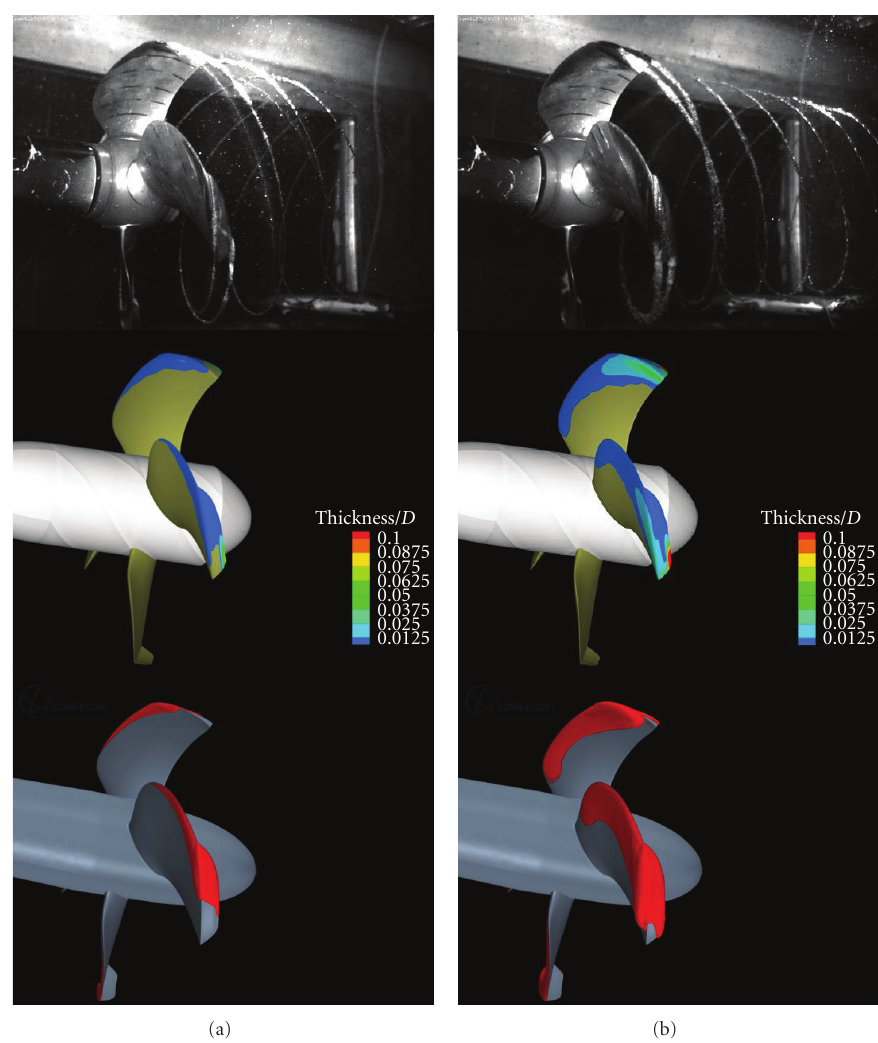
Figure 23: Cavity extension for open water KT equal to 0.173 (a) and 0.253 (b), at cavitation index of 1.625. Comparison with panel and RANSE numerical